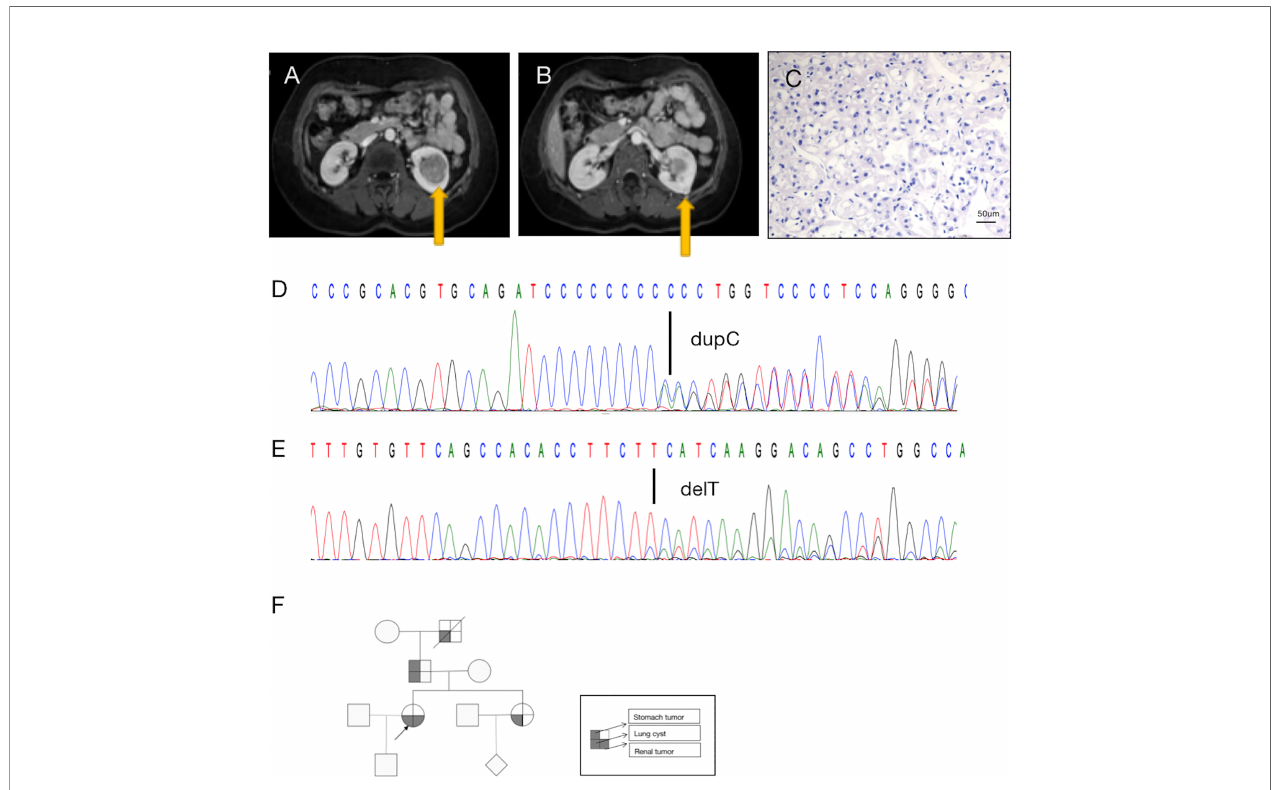
FIGURE 1 | A diagnosis of BDH syndrome was con fi rmed in the patient. (A) Abdominal magnetic resonance imaging (MRI) revealed a renal mass in the lower middle part of the left kidney (arrow). (B) MRI with intravenous contrast revealed a renal mass in the posterolateral surface of the left kidney (arrow). (C) Histopathology of the small tumor in the left kidney shows cells with classic plant-like architecture, perinuclear clearing (chromophobe cell carcinoma). (D) Germline mutation: base C duplication at nucleotide c.1285dupC in exon 11 (c.1285dupC) of the FLCN gene. (E) Somatic mutation: a base T deletion at nucleotide c.470 in exon 6 (c.470delT) of the FLCN gene. (F) Pedigree summarizing the family history of the proband (arrowhead). Different symbols indicate different